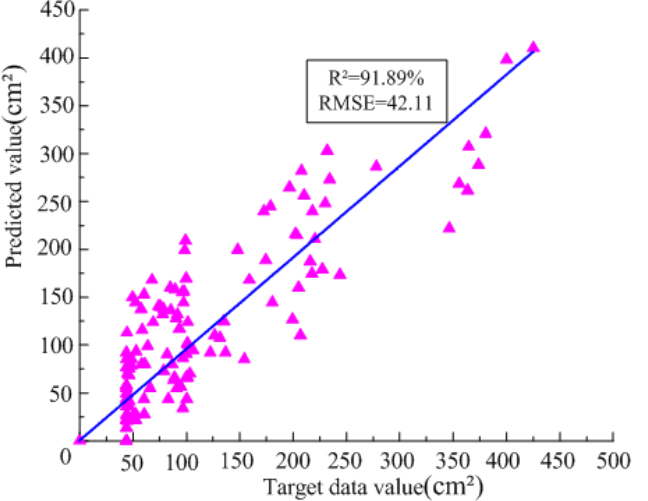
Figure 13. Relationship between the real and predicted values of the BP neural network test set.